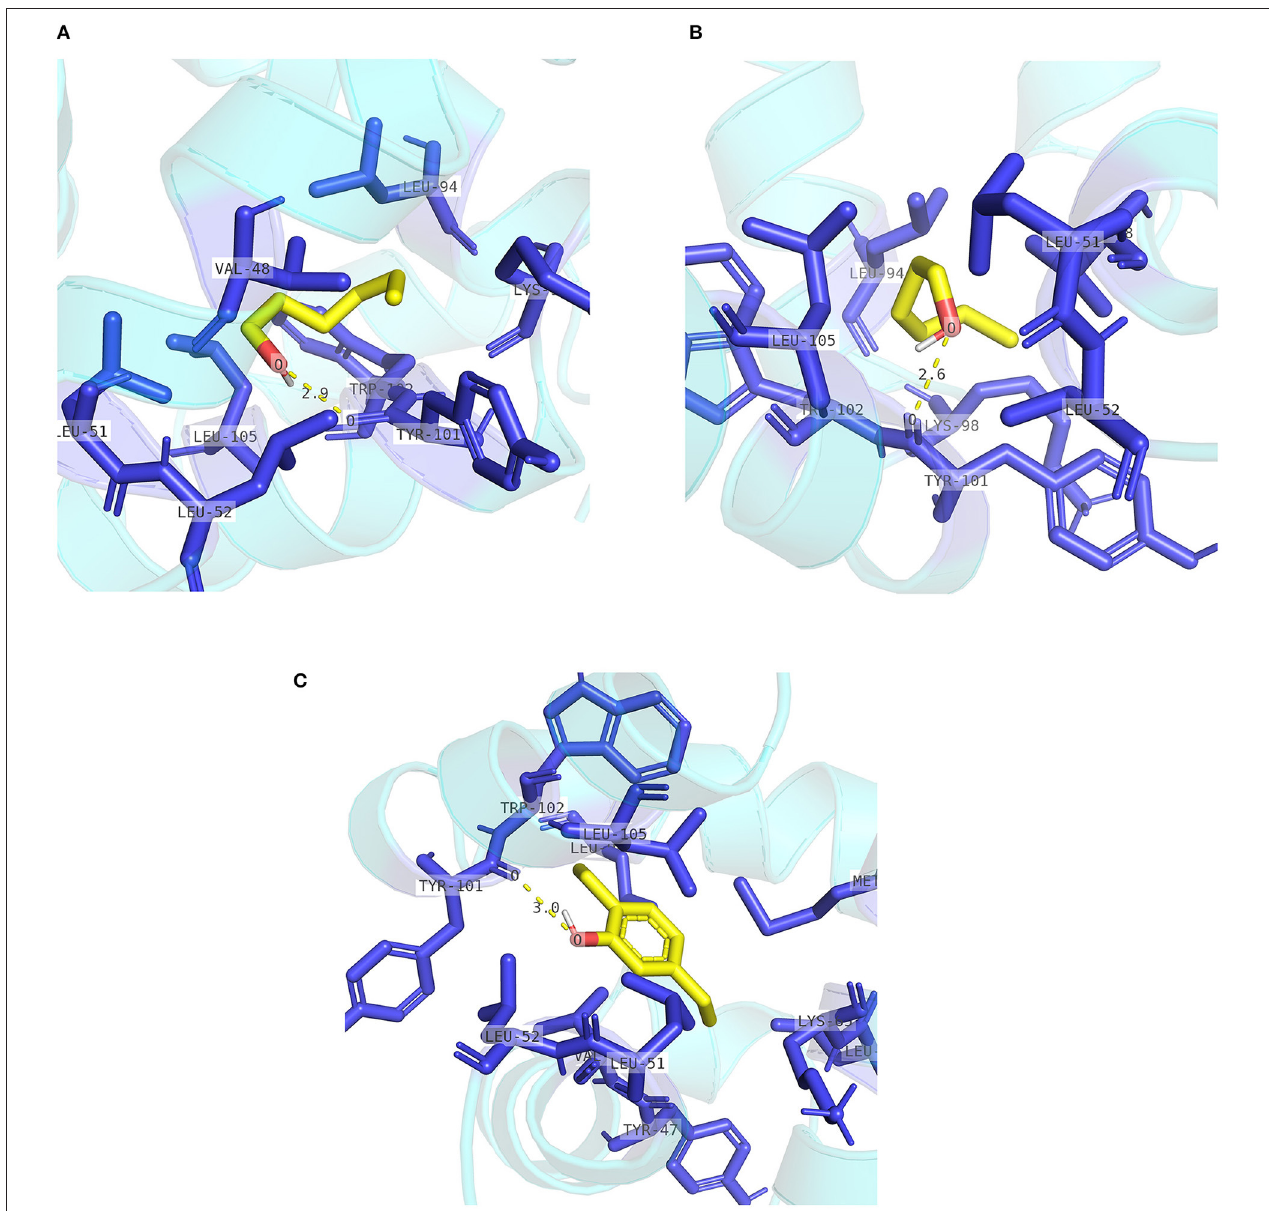
FIGURE 8 | Internal contacts of ligands with EbraCSP8 residues. Blue sticks represent non-ligand residues involved in hydrophobic contacts; yellow dotted line represent hydrogen bond and its length. (A) Internal contacts of 1-hexanol with EbraCSP8 residues. (B) Internal contacts of cis-3-hexen-1-ol with EbraCSP8 residues. (C) Internal contacts of 2,5-diethylphenol with EbraCSP8 residues.